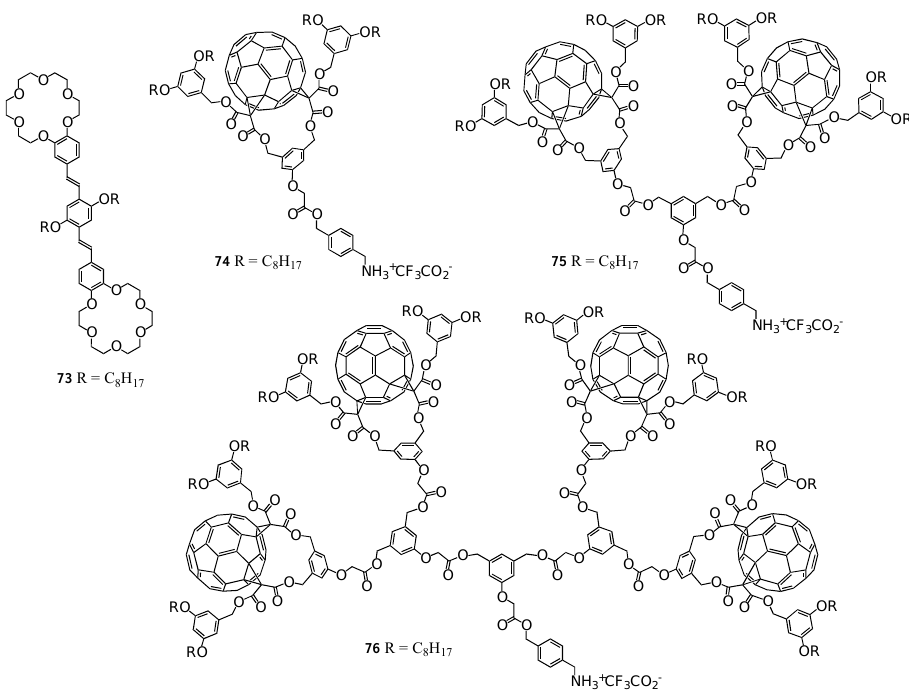
Figure 10. Structures of ditopic OPV host 73 and ammonium-containing dendrons of first to third generation 74 - 76